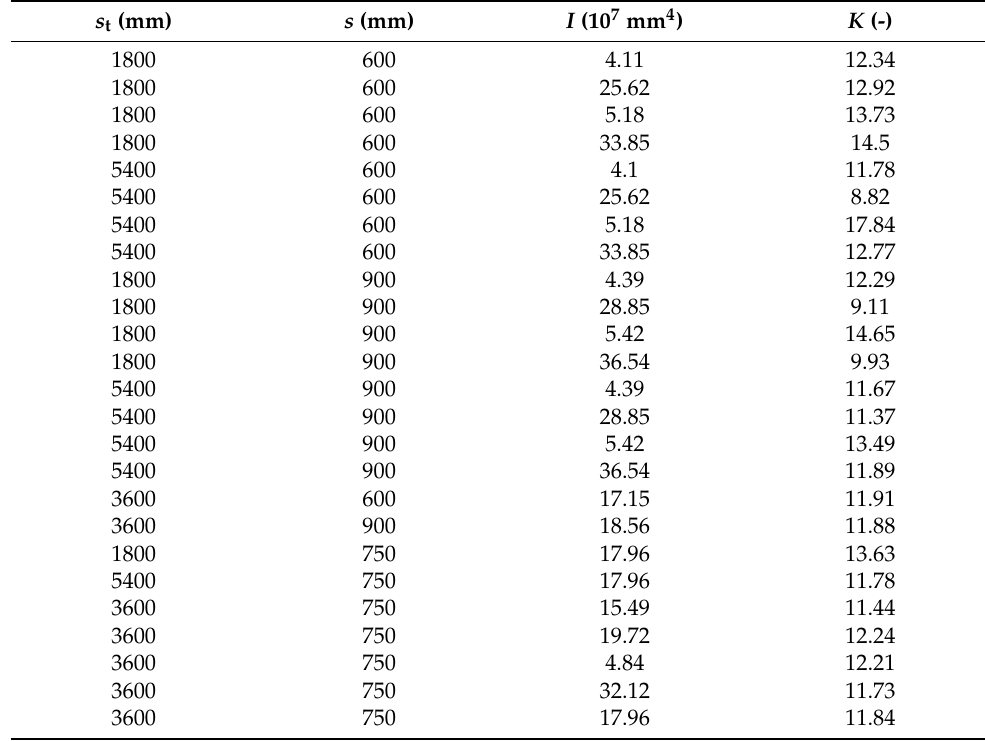
Figure 13. Box plot for the value of k. Table 6. The coefficient k in relation with s t , s and I